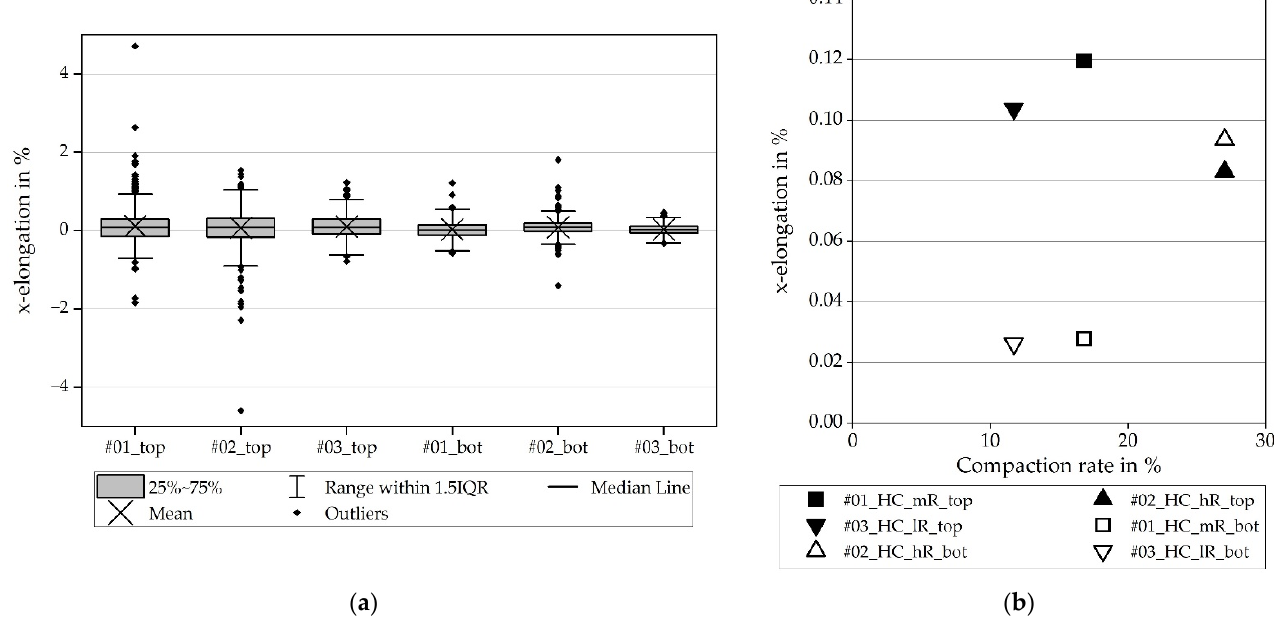
Figure 12. Elongation in x-direction for the hard carbon anode, coating (_top) and current collector foil (_bot): ( a ) elongation with scatter; ( b ) average values .